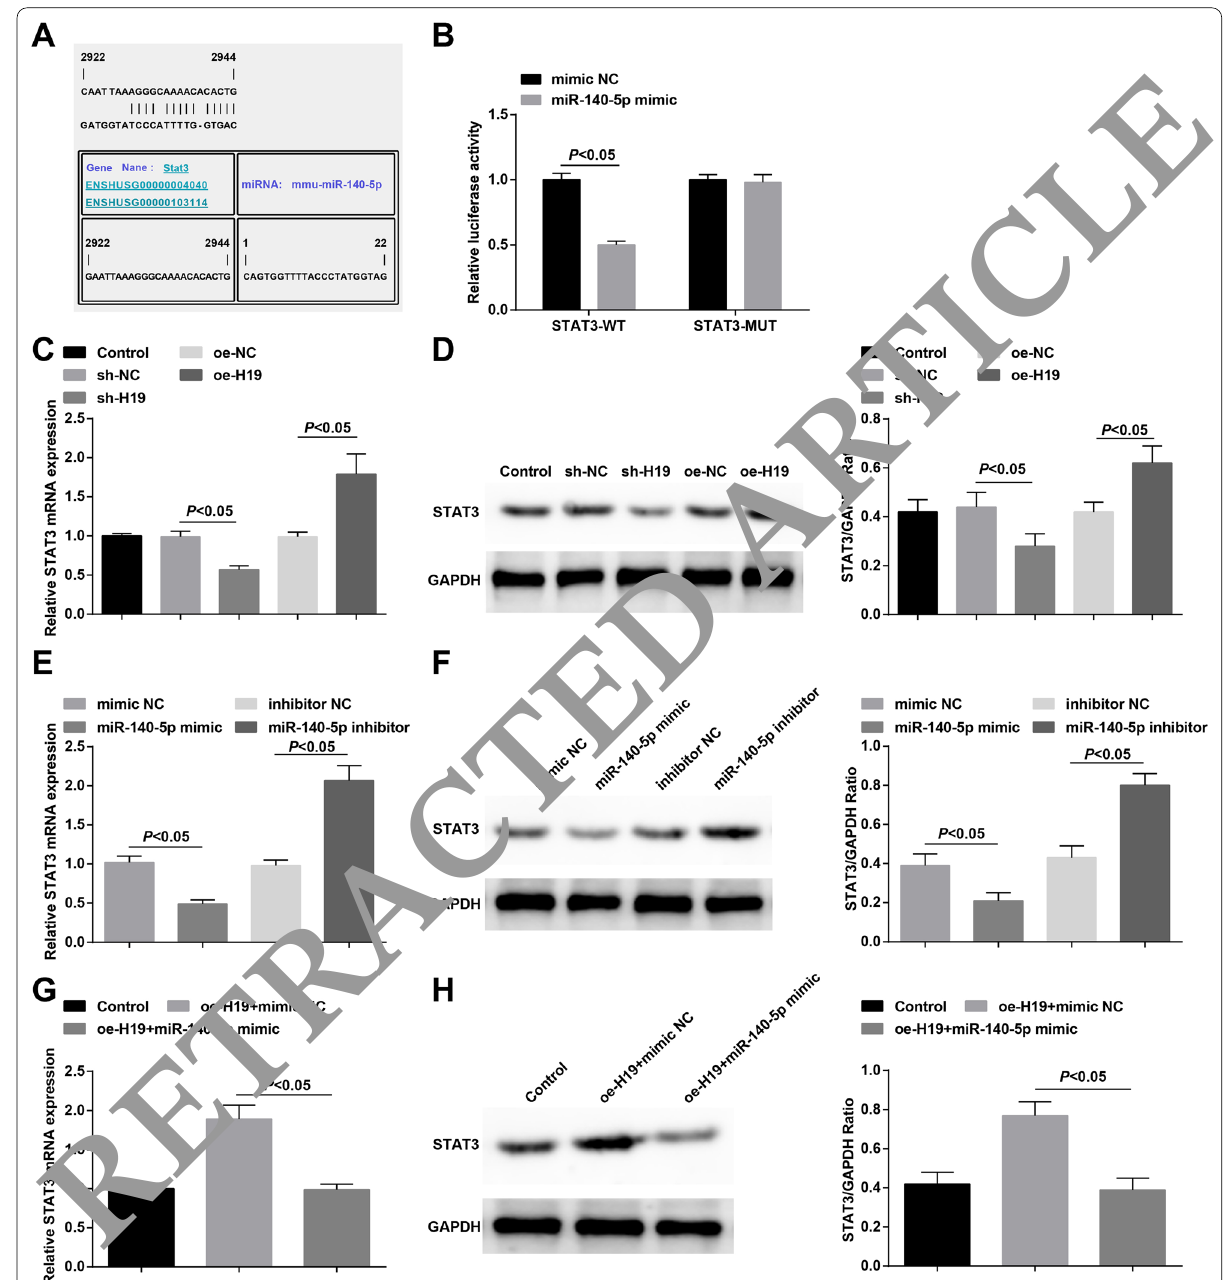
Fig. 6 H19 binds to miR-140-5p to modulate STAT3. A The binding site of miR-140-5p and STAT3 detected by bioinformatics website; B The targeted regulatory relationship between miR-140-5p and STAT3 detected by dual luciferase reporter gene assay; C – H STAT3 expression detected by RT-qPCR and western blot assay; N 3. The data were expressed as mean standard = ±